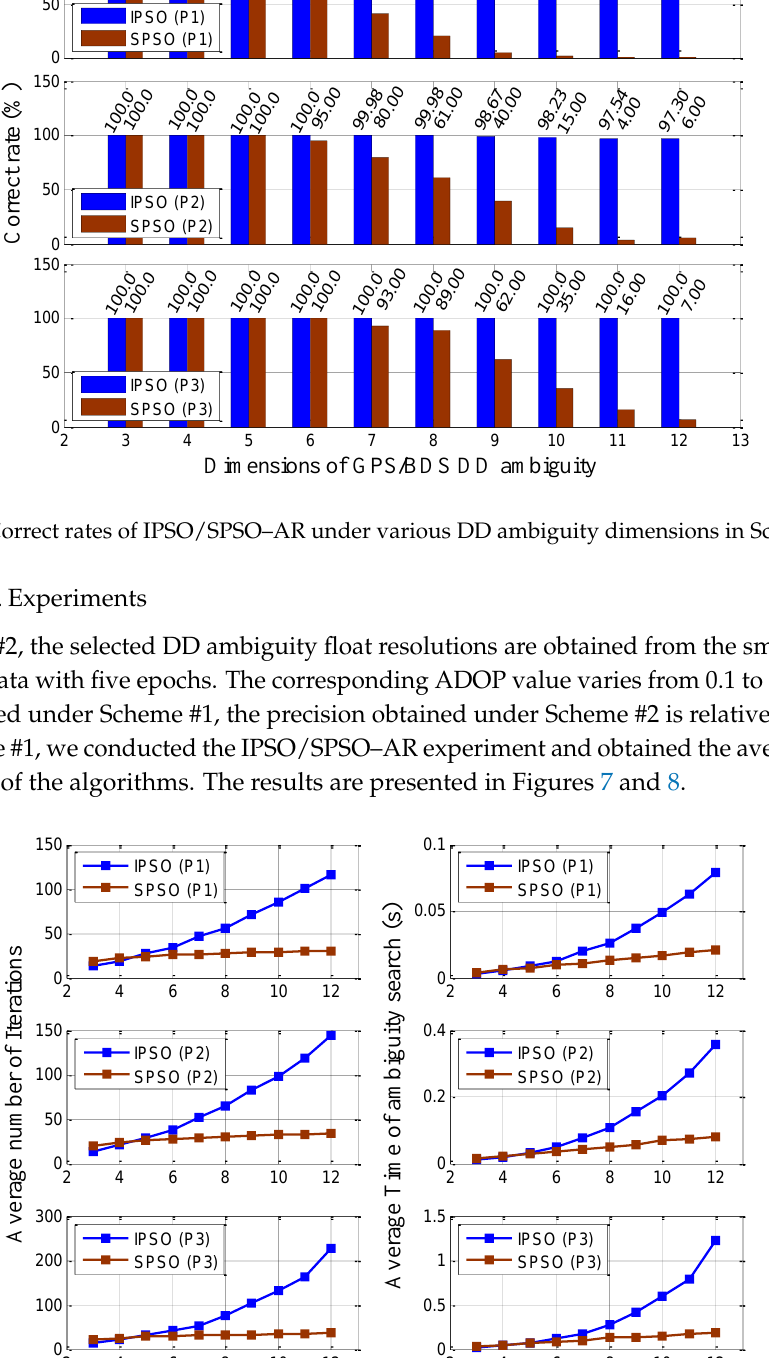
Figure 7. Average number of iterations and search time of IPSO/SPSO–AR under various DD ambiguity dimensions in Scheme #2.